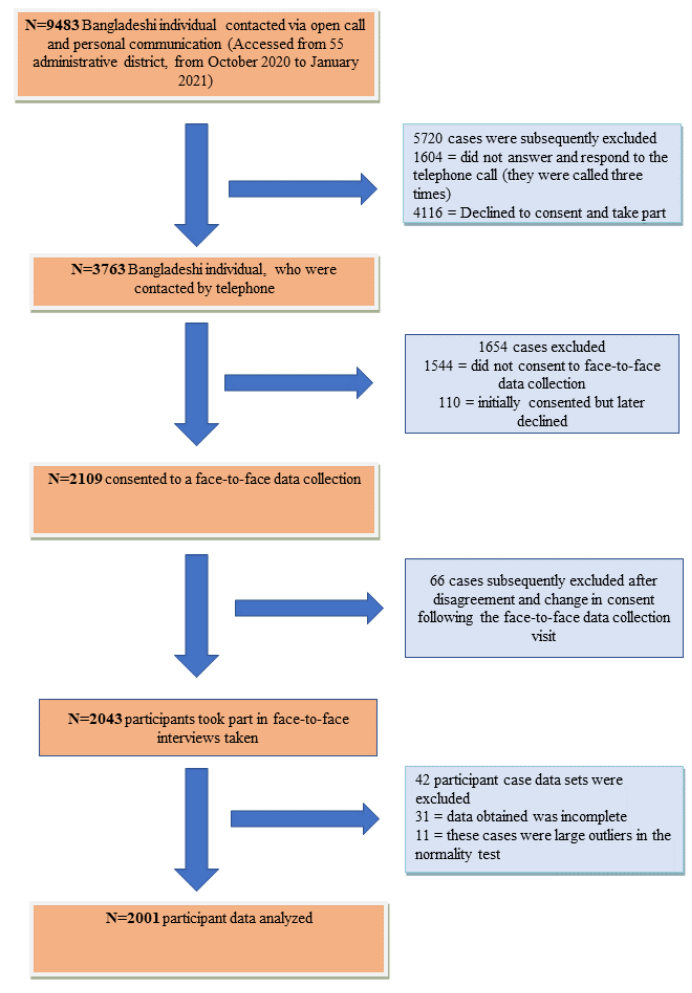
Figure 1. Flow diagram of the population distribution of this study